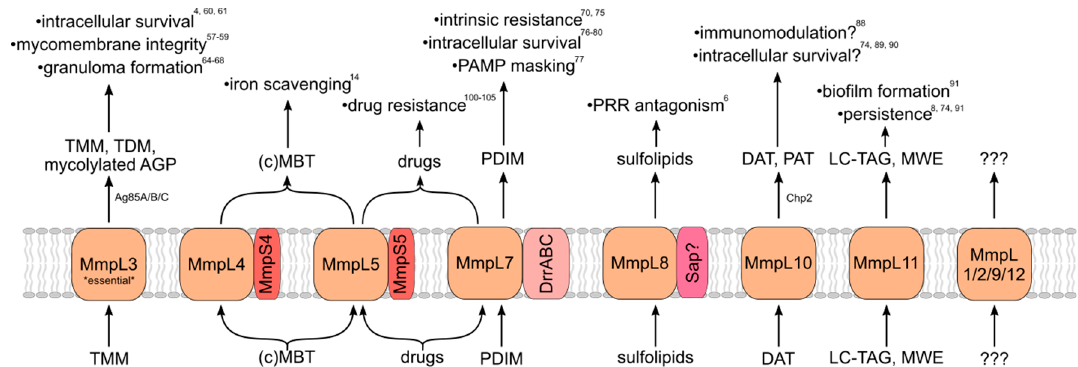
Figure 2. MmpL transporters export substrates that are important for virulence and pathogenicity. MmpL proteins and membrane-associated transport partners, exported substrates, and contributions to virulence/pathogenicity of the mature exported substrates.